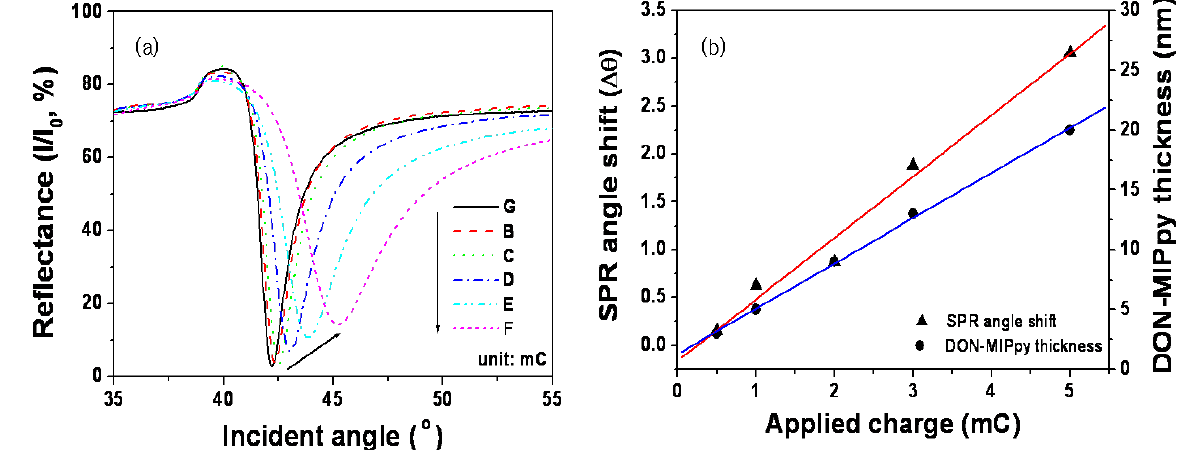
Figure 1. SPR spectra (a) and thickness change (b) during the formation of